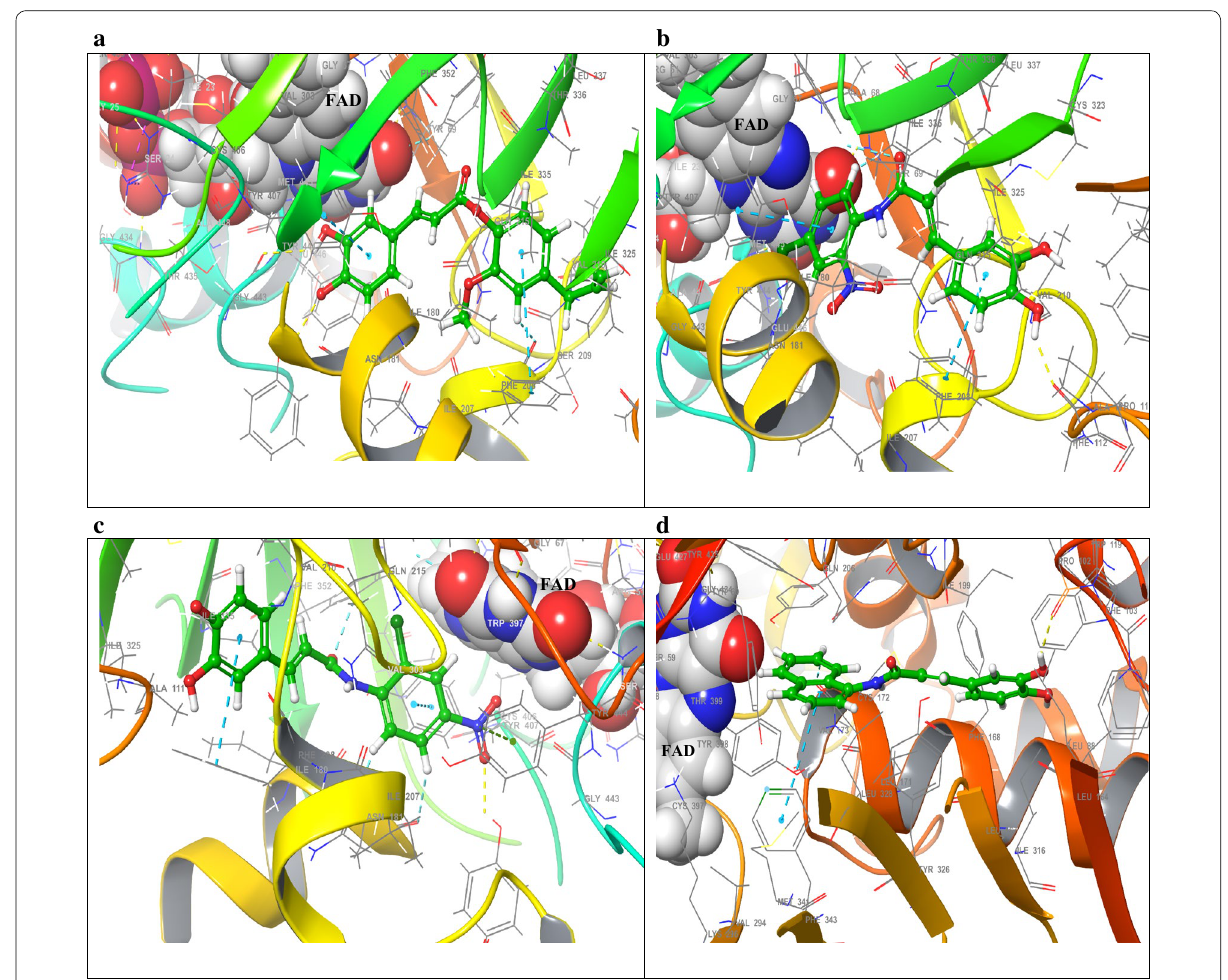
Fig. 9 Graphical illustration of predicted binding mode of compounds 7, 2, 1 (within the hMAO-A binding site) and 5 (within the hMAO-B binding site) as into a – d respectively. Ligands are depicted in green carbon sticks. Major interacting amino acid residues are as gray carbon sticks, while FAD is in space-fill. Blue dotted lines specify ligand–enzyme π–π stacking interaction; yellow dotted lines signify ligand–enzyme intermolecular hydrogen bonds; green dotted lines signify ligand–enzyme π–cation stacking interaction. Hybrid caffeic acid derivatives as monoamine oxidases inhibitors: synthesis, radical scavenging activity, molecular docking studies and in silico ADMET